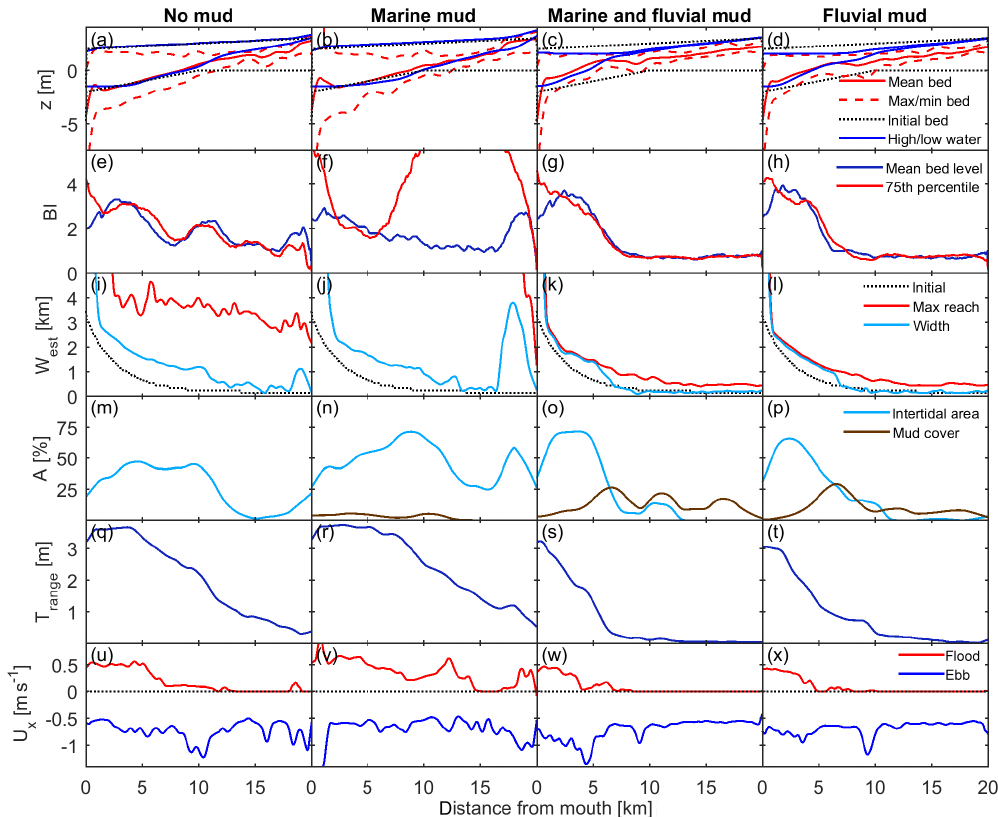
Figure A11. Hydrodynamics and morphology along estuaries for different mud sources in the presence of waves after 2000 years. From left to right (columns): model with only sand (28), marine mud supply (27), supply from both boundaries (25) and fluvial supply (29). (a–d) Minimum, mean and maximum bed elevation, high and low water level and minimum and maximum initial bed level, (e–h) braiding index and (i–l) estuary width defined as the initial width, maximum reach over the whole scenario run, the width of wet cells in the model, width defined by a threshold value that is used to mask the cells that are around the dry–wet cell threshold. (m–p) Intertidal area and mud cover as a percentage of the total area, (q–t) tidal range and (u–x) peak ebb and flood